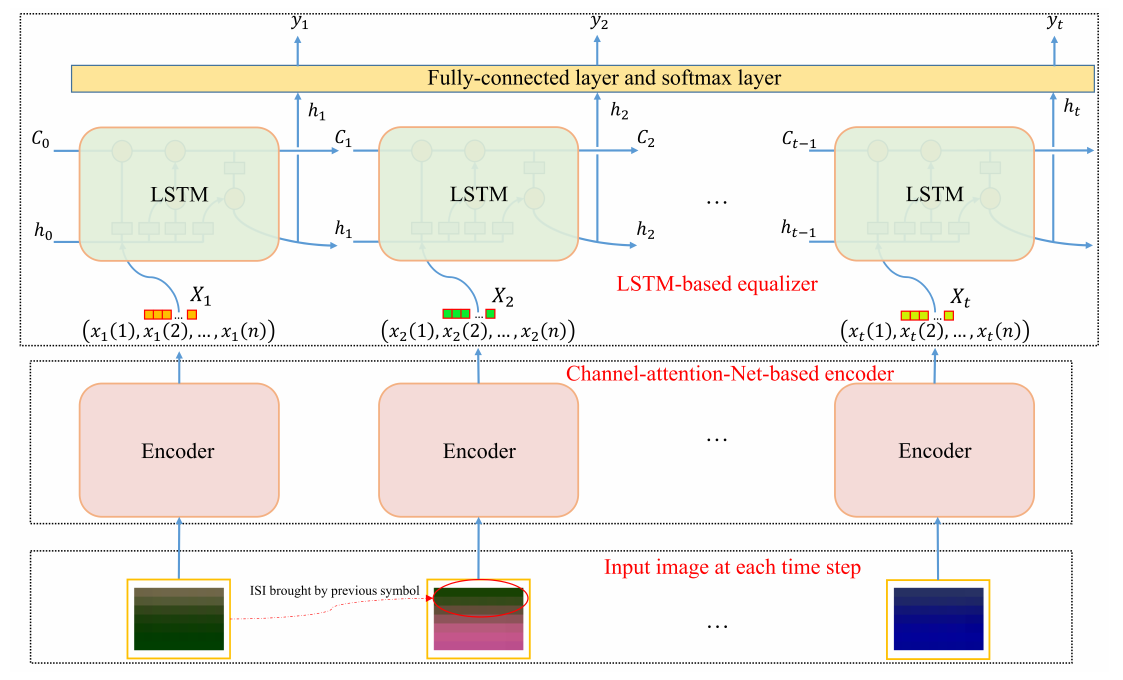
Figure 6. Sketch map of the structure of the proposed